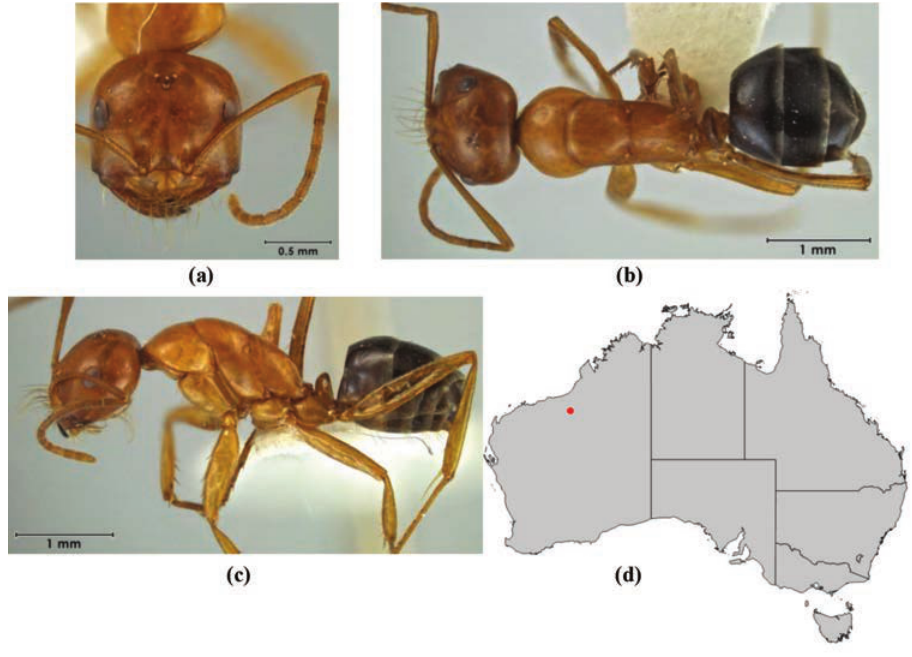
Figure 66. Melophorus orthonotus sp. n.: holotype media worker (JDM32-004590) frons ( a ), profile ( b ) and dorsum ( c ); distribution map for the species ( d